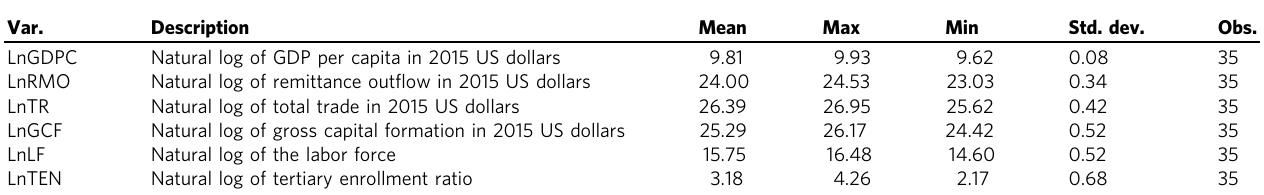
Table 1 Variable speci fi cations.